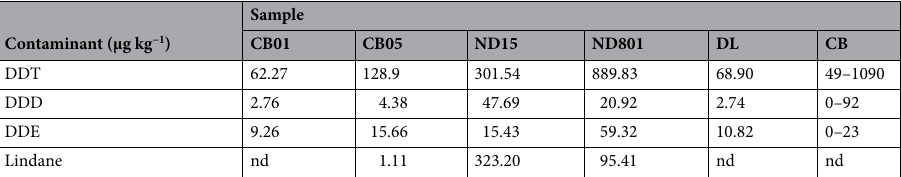
Table 1. Contents of organochlorine pesticides in contaminated soils collected from three different locations in Vietnam. nd indicates not detectable. CB01 and CB05 are samples taken in Cam Binh commune, Cam Xuyen district, Ha Tinh province. CB01 was sampled right at the place where stood the old storehouse and where the field trial took place. CB05 was sampled in the surrounding area at 5 m from CB01. ND15 and ND801 were sampled at a 15 m distance nearby the storehouse and right at the old storehouse for plant protection chemicals in Nam Dinh province, respectively. DL was sampled at a contaminated area in Doi Lim, Bac Ninh province. CB01, CB05, ND15, ND801, and DL were taken in a survey in 2019, while CB, named for samples taken at the trial site, were obtained at the starting time of the field trial in December